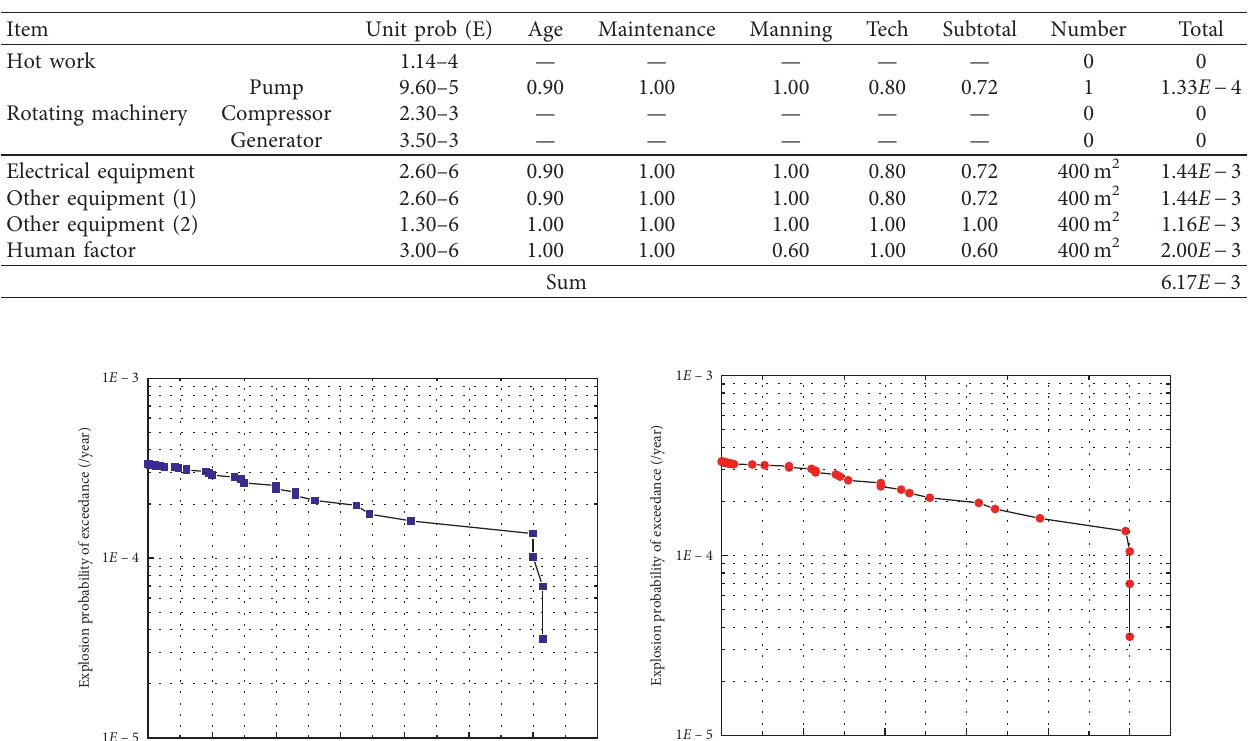
Table 7: Ignition probability calculation.